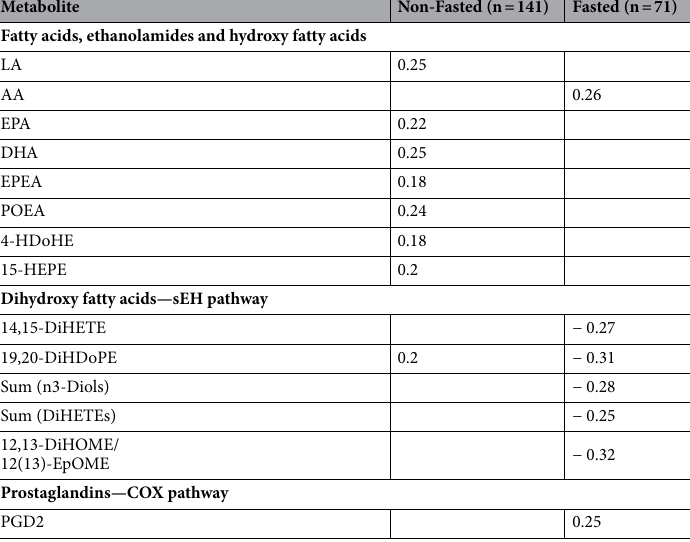
Metabolite Non-Fasted (n = 141) Fasted (n =